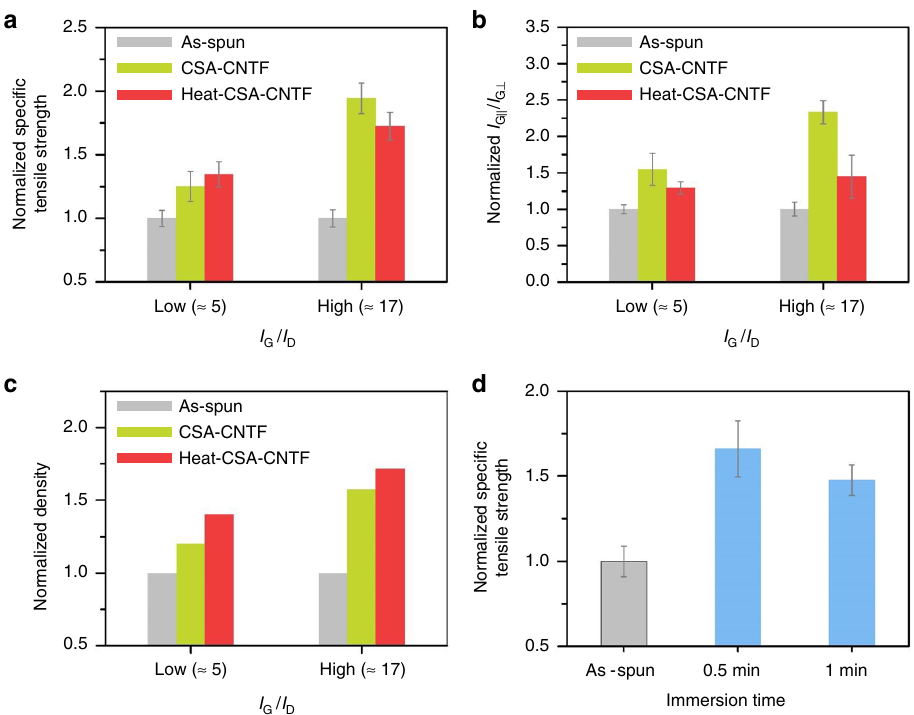
Fig. 6 Combinational effect of I G / I D and heat treatment. a Normalized speci fi c tensile strength, b normalized I G ∣∣ / I G ⊥ , and c normalized density of as-spun CNTF, CSA-CNTF, and heat-CSA-CNTF with low and high I G / I D s. The immersion time and the stretching ratio in ( a ) – ( c ) were 1 min and 10%, respectively. d Normalized speci fi c tensile strength of heat-CSA-CNTF that had medium I G / I D as a function of immersion time. The stretching ratio in ( d ) was 10%. All real values of speci fi c strength, I G ∣∣ / I G ⊥ , and density were normalized to those of as-spun CNTF. Error bars represent the standard deviation. All real values are presented in Supplementary Fig. 10, including the numbers of